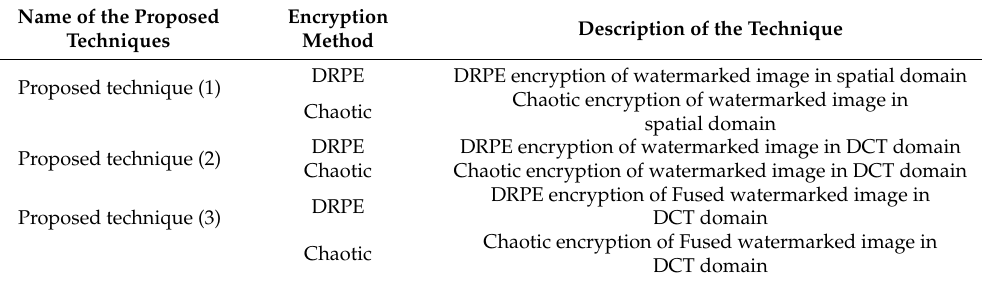
Table 1. The three different proposed techniques.